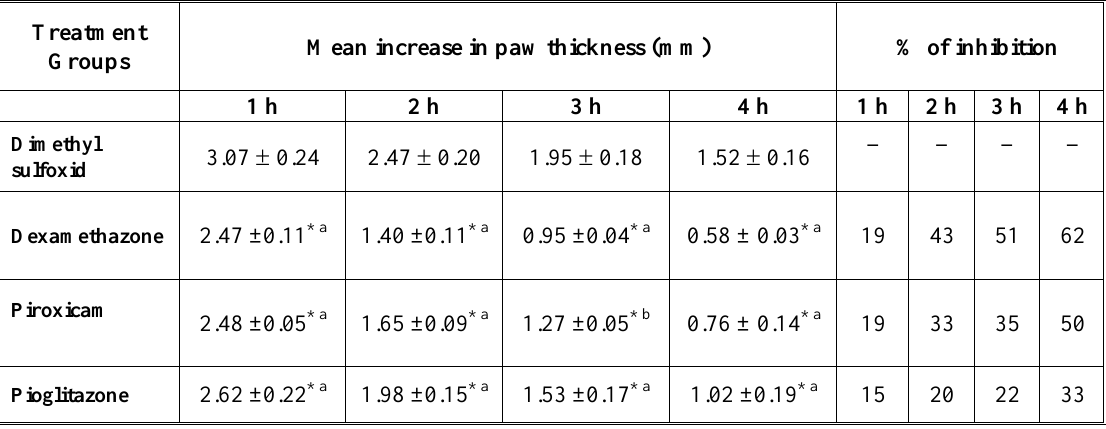
Table 1. Effect of Pioglitazone on egg albumin-induced acute inflammation in rats.